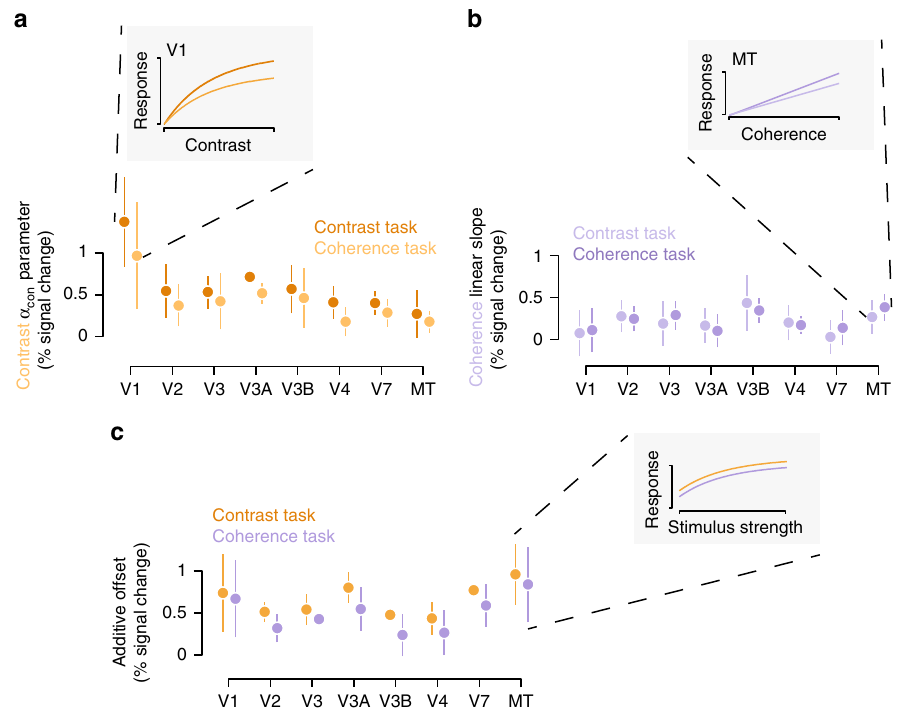
Fig. 3 Cortical measurements during active viewing. Observers performed the behavioral task while hemodynamic responses in retinotopic visual cortex were measured. a The average across observers of the α con parameter, a measure of contrast sensitivity, is shown for each task context (dark and light markers are the contrast and coherence task, respectively). Inset shows how the change in the parameter affects the change in the contrast response function for V1, ignoring any change in additive offset. b As in a for coherence sensitivity, as measured by the linear slope of the coherence response function (dark and light markers are coherence and contrast task, respectively) and inset shows the relationship for MT. c As in a , b for the α task parameter, which absorbs additive offsets. Inset shows the additive offset shift for MT